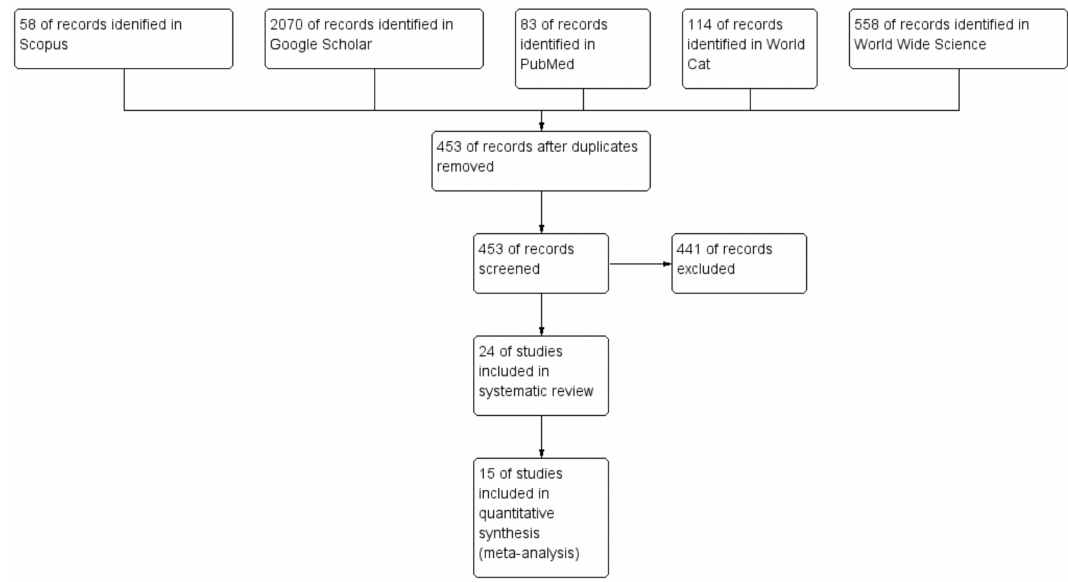
Table 1: 3, 10, 11); the other seven studies were classified as CLS [31,37–41] (study ID in Table 1: 7, 13, 14, 20–22).